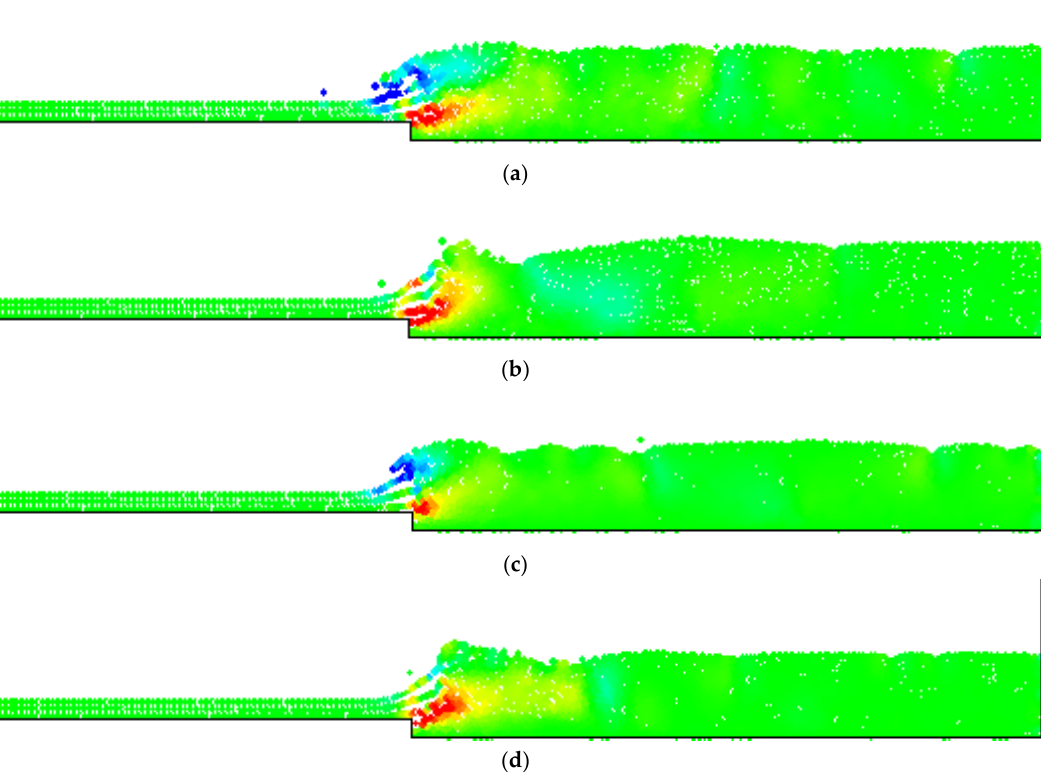
Figure 7. Instantaneous SPH vorticity field in the SPH simulation of Test T1a: ( a ) t = 8 s; ( b ) t = 17 s; ( c ) t = 22 s; and ( d ) t = 27 s. Vorticity values in the colour scale are expressed in s −1 .